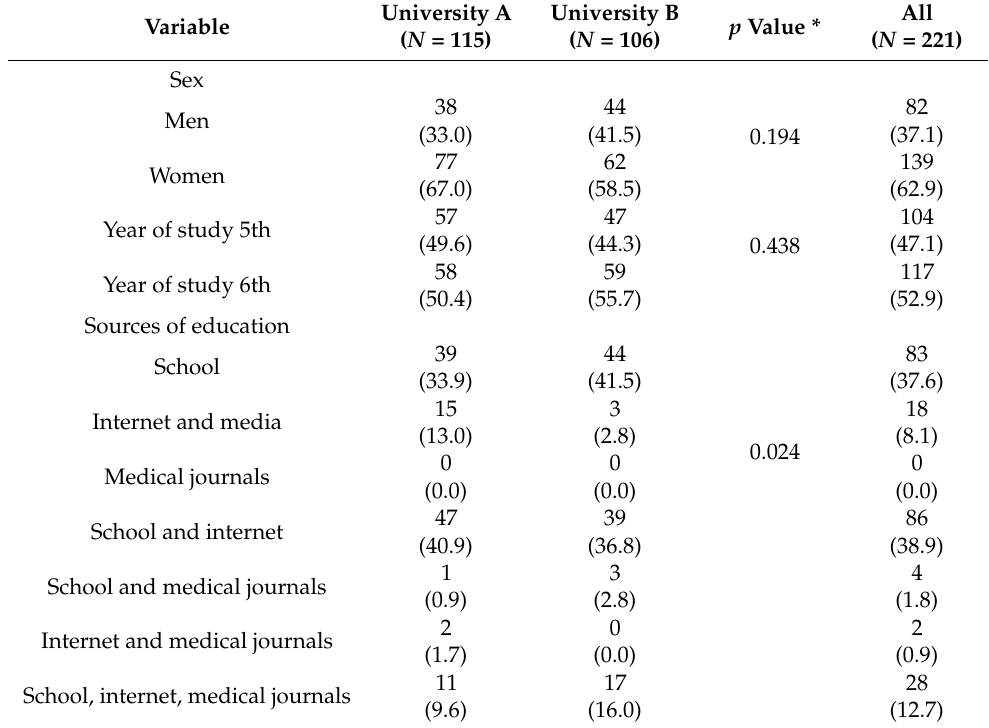
Table 1. Characteristics of study